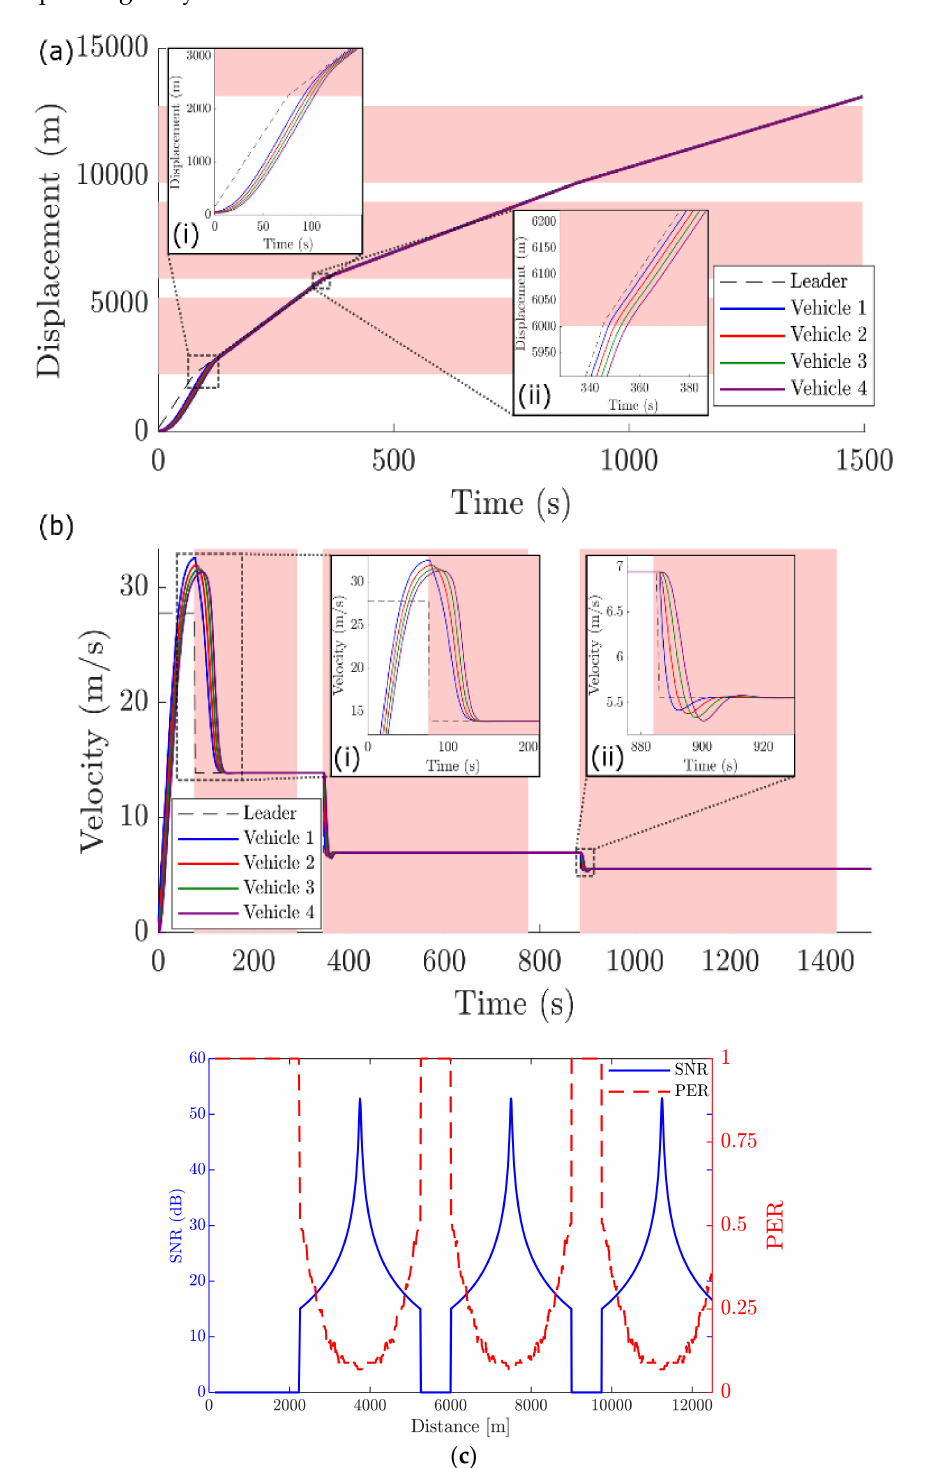
Figure 7. Case I vehicle platoon motion as described in Section 3.4: ( a ) Displacement of the vehicles over the simulation time. The inset shows a magnified image of the vehicle movement as the platoon enters the RSU coverage; ( b ) Velocity of the vehicles over the simulation time. The inset shows a magnified image of the vehicle velocities as the platoon enters the RSU coverage; ( c ) Variation of SNR and PER as the platoon moves along the road. Leader is the platoon